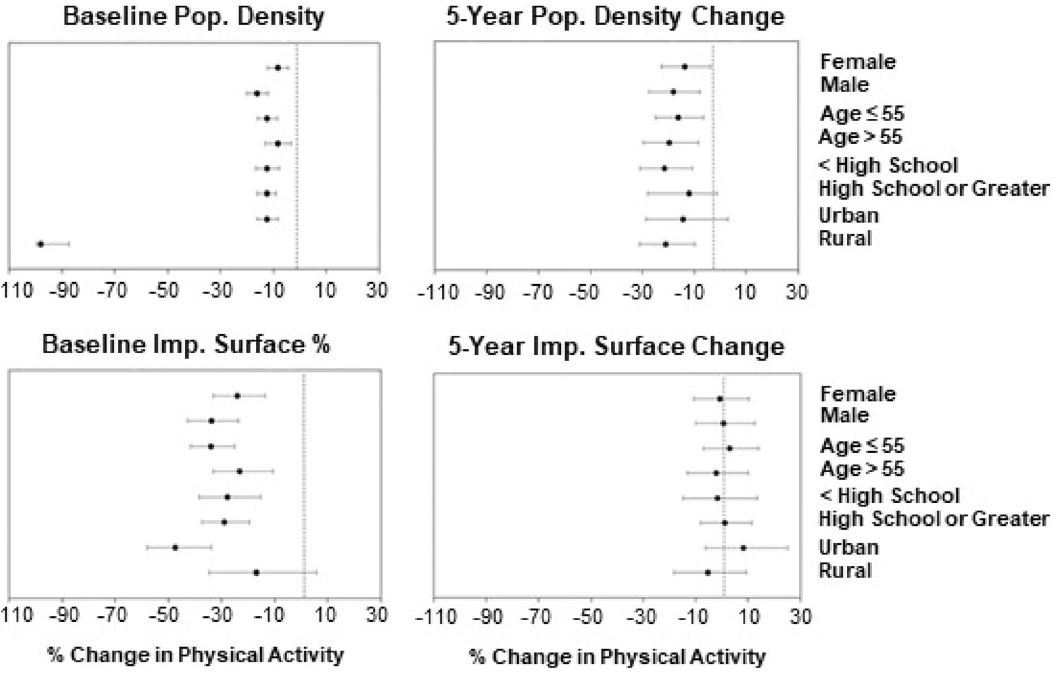
Figure 2. Adjusted associations between urbanization measures and total physical activity by sex, age, education and urban/rural